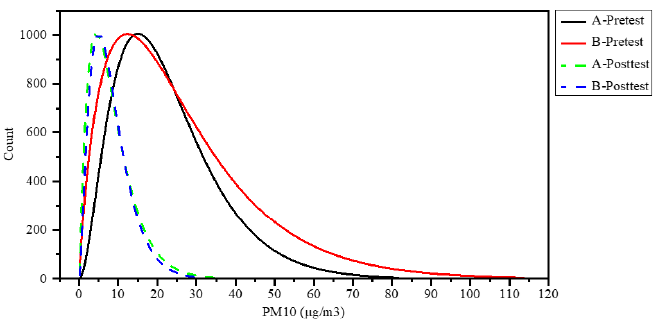
Figure 10. Distribution curve of PM 10 concentrations before and after the implementation of the improvement plan.